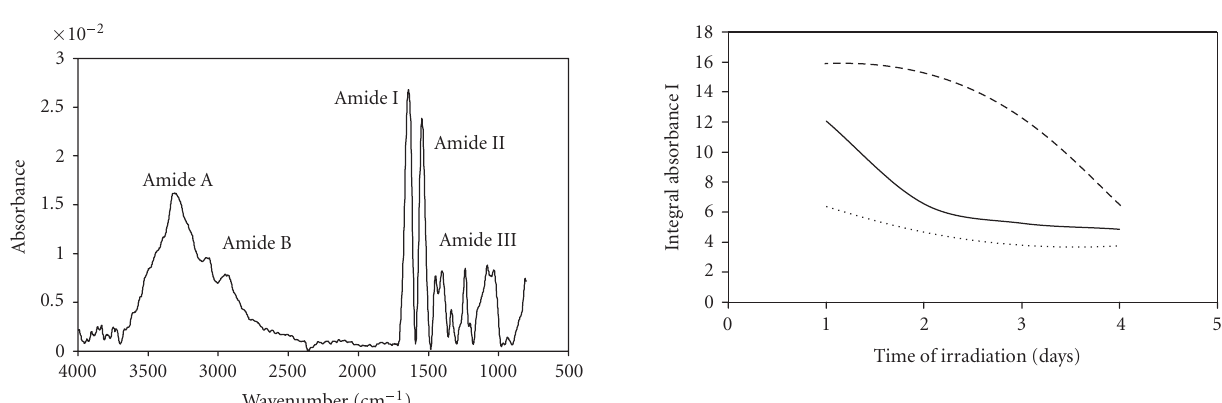
Figure 5: The changes of integral absorbance of Amide I band in FTIR spectra during solar irradiation of collagen (solid curve), col- lagen/PVA (dotted curve), and collagen/PVP films (dashed curve), key to time and dose of solar radiation in Table 1.